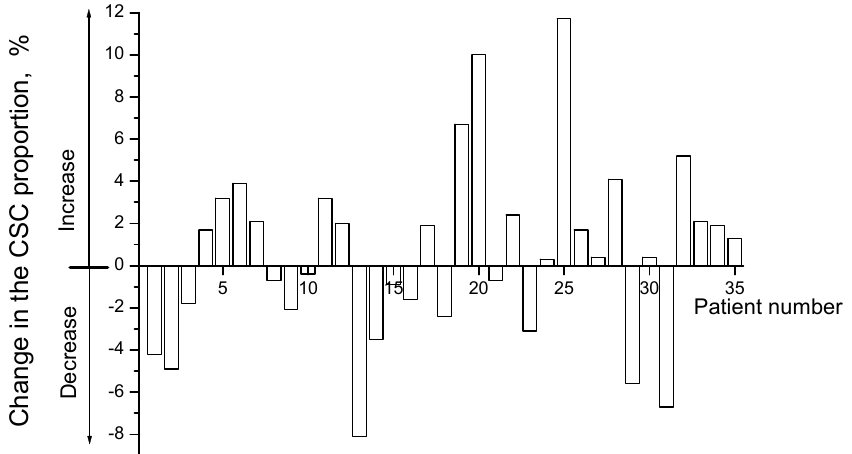
Figure 4. Changes in the proportion of CD44 + CD24 low cancer stem cells (CSCs) in cervical scrapings from 35 cervical cancer (CC) patients 24 h after radiation exposure at a TD of 10 Gy. Positive values indicate an increase in the proportion of CSCs after irradiation, and negative values indicate a decrease in this indicator.